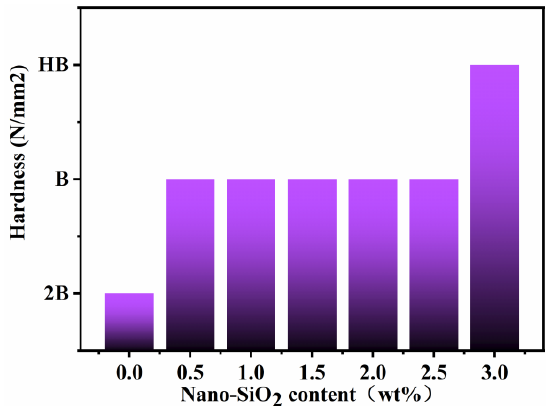
Figure 5. Effect of nano-SiO 2 content on the hardness of WAA paint film.